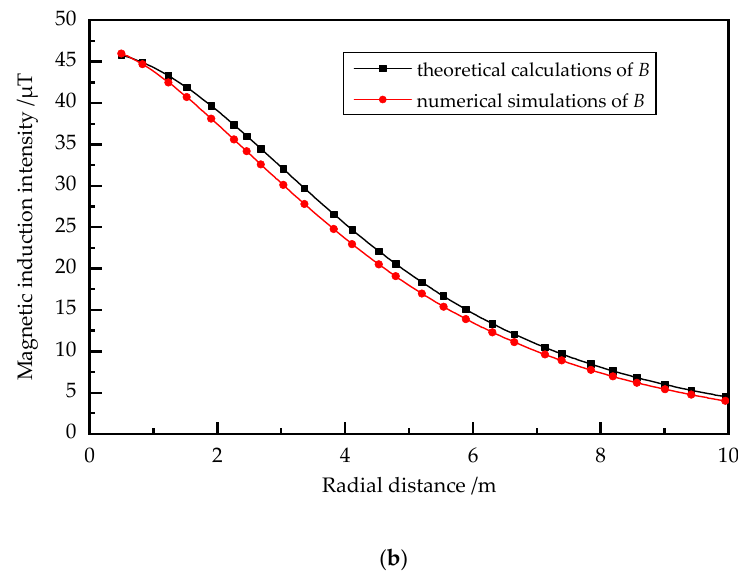
Figure 5. Variations of magnetic induction intensity along two radial test lines (longitudinal positions z = 0 m and z = 6 m) under N–N connection condition. ( a ) Variation on the cross-section at the longitudinal position z = 0 m; ( b ) variation on the cross-section at the longitudinal position z = 6 m.